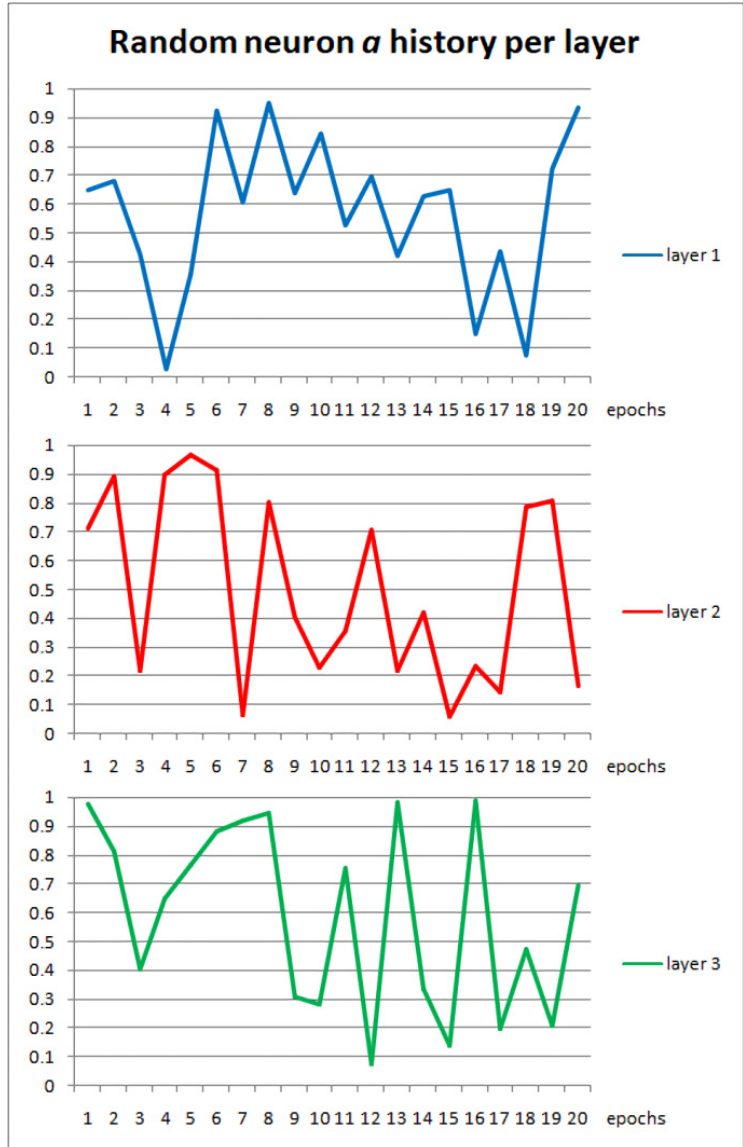
Figure 3. Values of parameter a during training for 3 neurons in different layers.